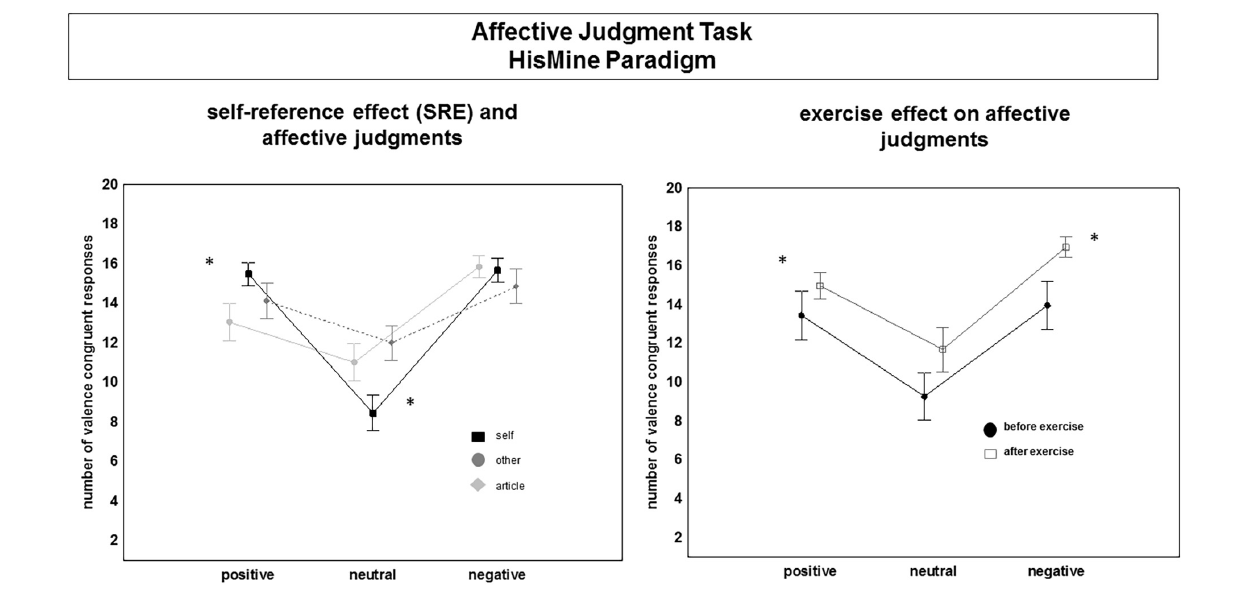
FIGURE 5 | Changes in affective judgments (accuracy) before and after the exercise session. Main effects and interaction effects. “*” indicates signficance. For details, see